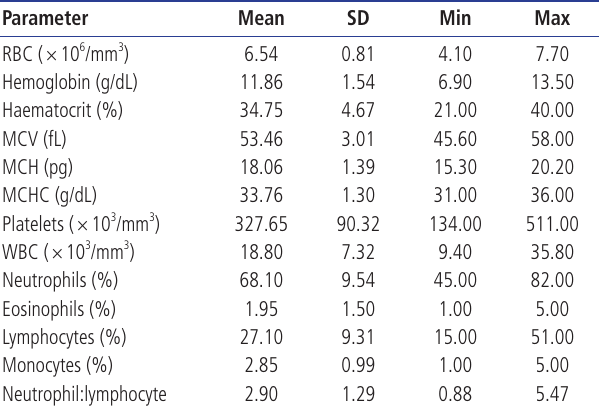
Table 1. Characterization of blood haematological parameters in pigs (n =